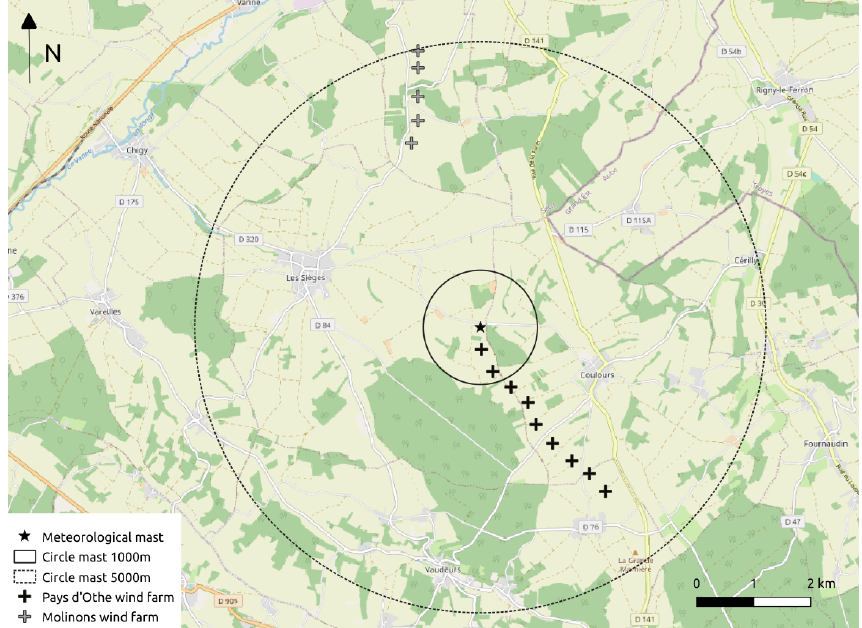
Figure 2. Map of the surroundings of the meteorological mast used. The background of the map is taken from OpenStreetMap (https: //www.openstreetmap.org/, last access: 16 August 2022, © OpenStreetMap contributors 2021. Distributed under the Open Data Commons Open Database License (ODbL) v1.0.). Forests are in green, farms are in light green, residential areas are in grey, and roads are in white (small ones) or orange